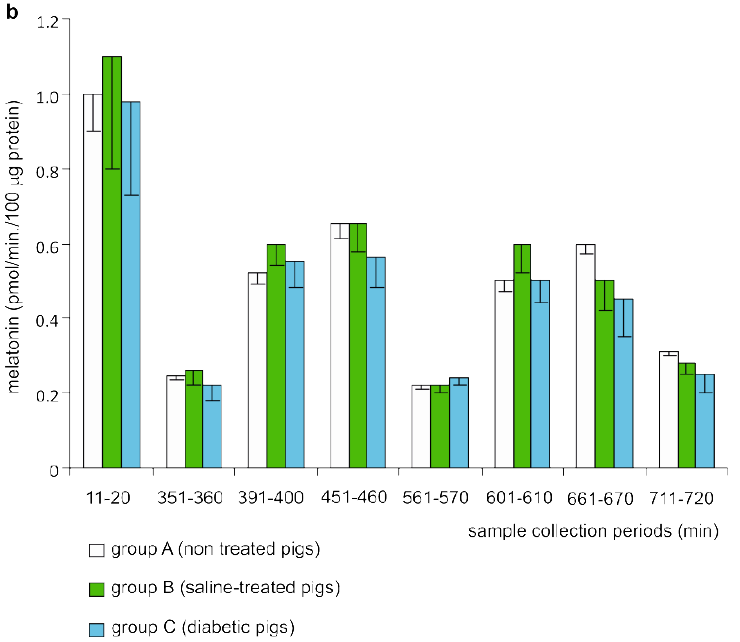
Figure 4. The levels of ( a ) N-acetylserotonin (NAS) and ( b ) melatonin (both measured by HPLC) in selected medium samples collected during the superfusion culture. For details of the experiment, see Figure 3. The values presented are means and standard errors ( n = 5).